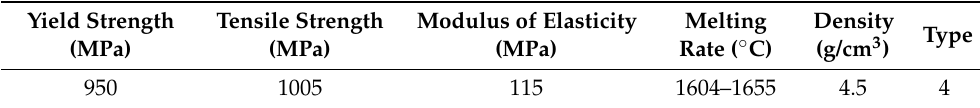
Table 1. Chemical composition of rematitan CL alloy [25]. Component Content (%) Ti 90 Al 6 V 4 Other components < 1%: N, C, H, Fe, O. Table 2. Technical parameters of rematitan CL alloy [25].